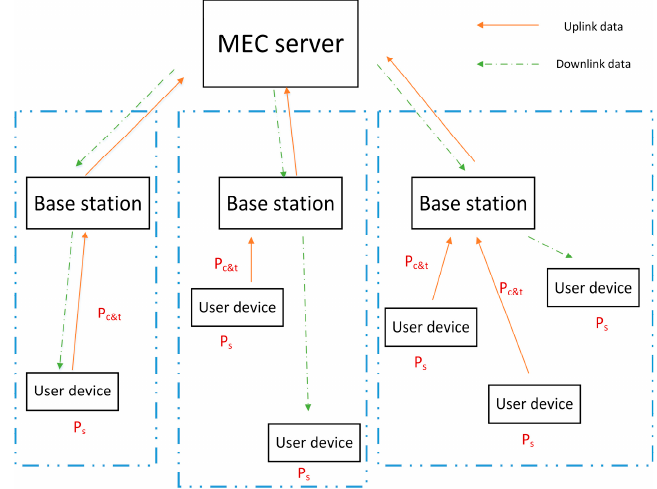
Figure 2. Overall model of optimization problem.